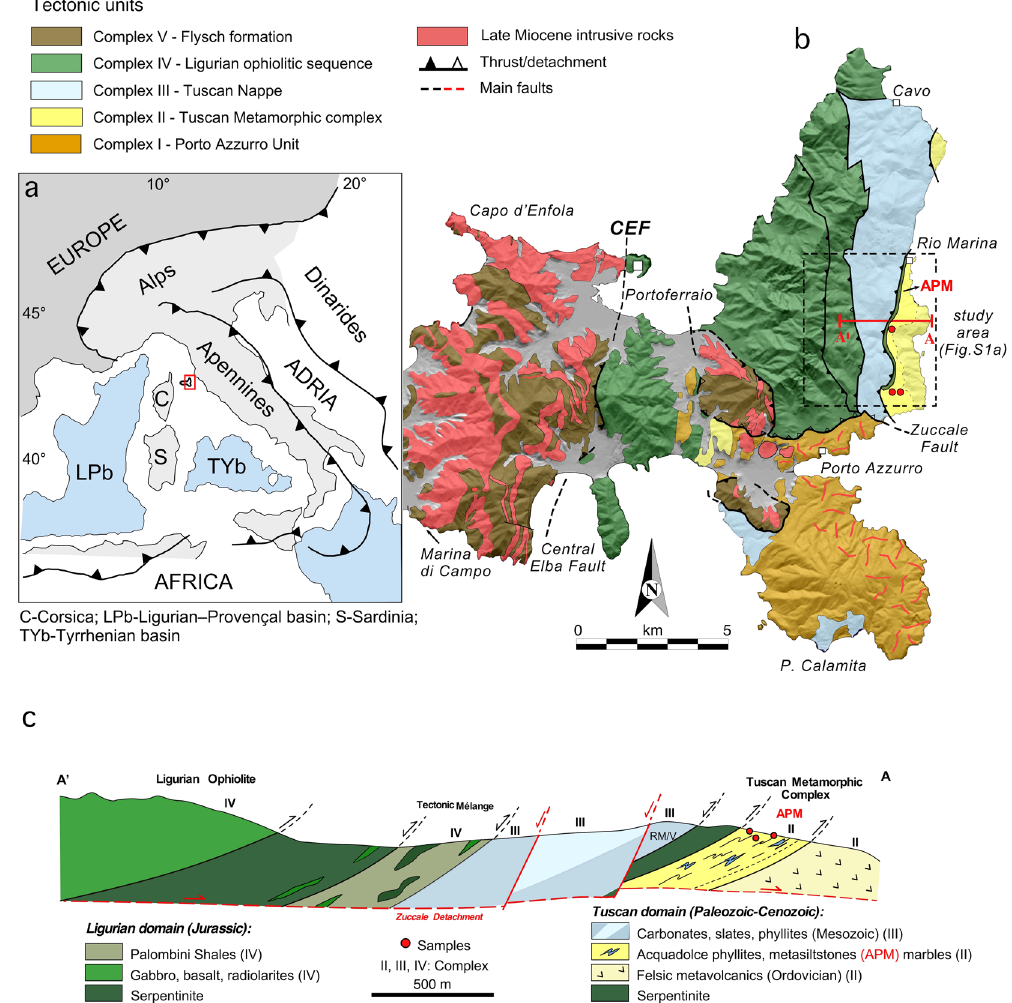
Figure 1. Geological setting of Elba Island. ( a ) Geodynamic sketch map of the central Mediterranean region. ( b , c ) Simplified geological map and schematic geological cross-section of eastern Elba Island, showing the stacked tectonic units and sample localities in the transition zone from the Tuscan Metamorphic Complex to the Ligurian Ophiolite (modified after 11,36,37 ). Abbreviations: CEF: Central Elba Fault; RM: Rio Marina phyllites; V: Verruca quartzites. The figs were created using Canvas Draw 3 (version 3.0.3) http://www.canvasgfx.com/en/